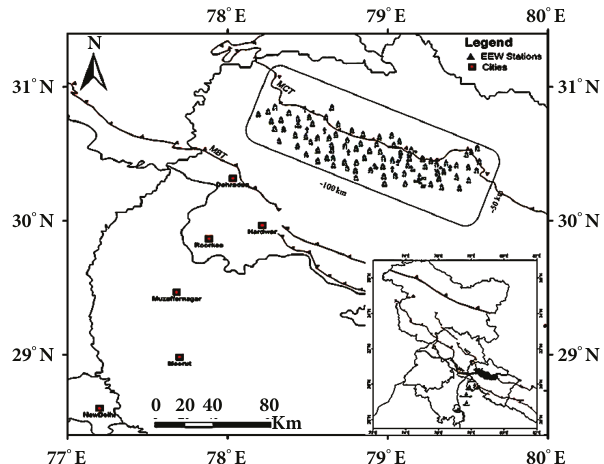
Figure 1: EEW instrumentation network in Uttarakhand region of Himalayas covering an area of around 5000 km 2 which is used to estimate lead times. EEW stations marked with triangles and the benefited cities for which EEW will be issued are marked with solid squares.